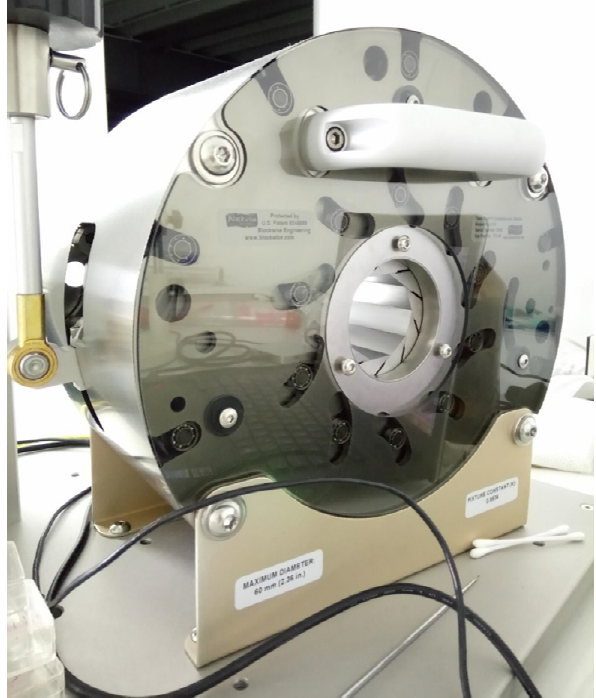
Figure 4. Crimping machine used in the stent compression tests. The machine was equipped with a radial force measuring head (friction compensated) and a thermal chamber.